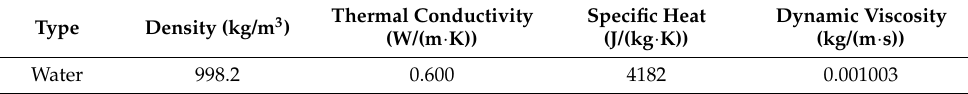
Figure 2. Simulation domain of SCP.